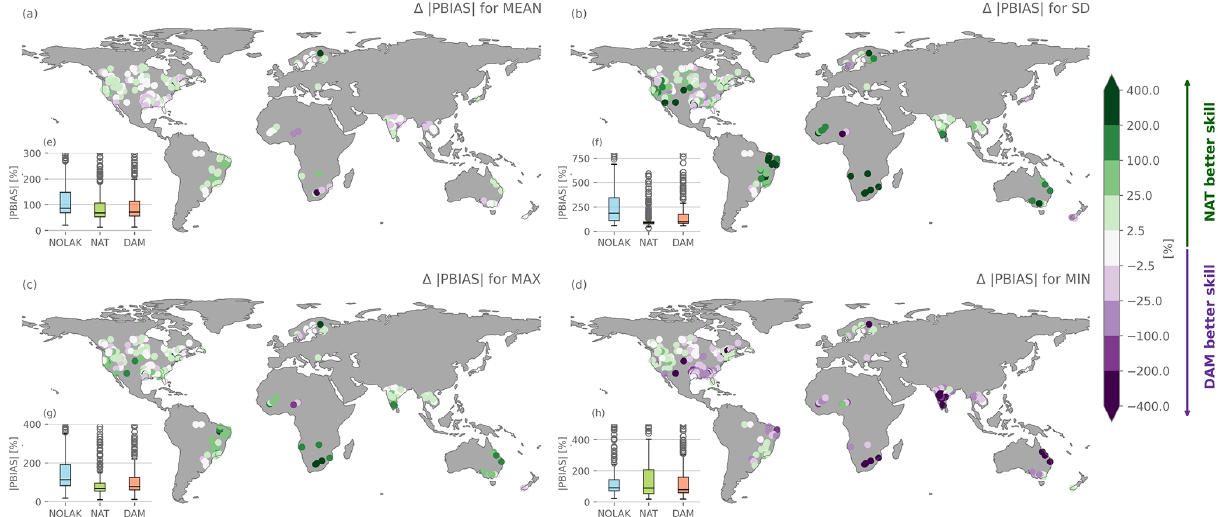
Figure A8. The same as Fig. 8 but for the absolute percent bias for natural lakes compared to reservoirs ( | PBIAS | DAM −| PBIAS | NAT ).